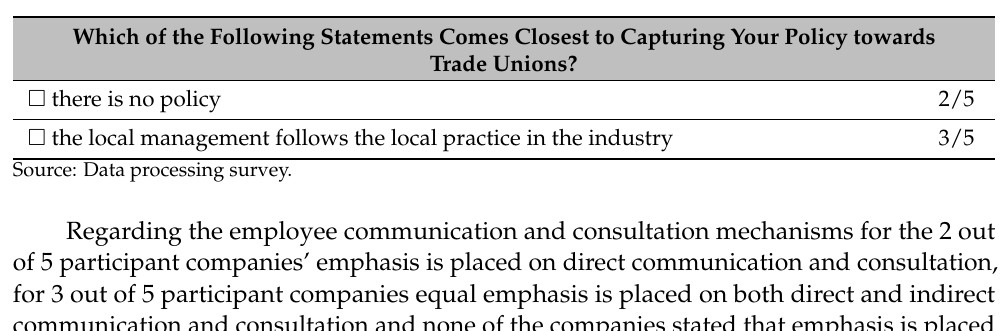
Table 7. Corporate policy towards trade